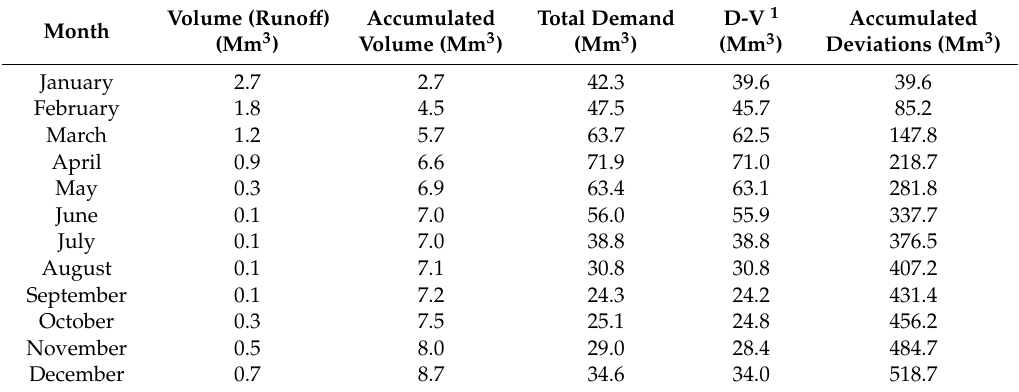
Table 6. Average Multi-annual Monthly Volume (runo ff ) vs. Demand for Guadalupe Basin.